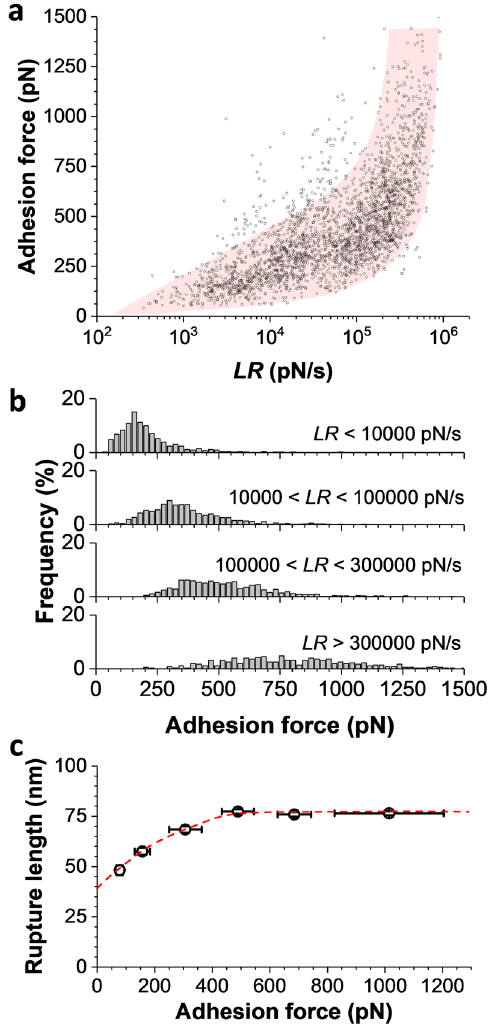
Fig. 6 Physical stress strongly enhances agglutination forces between MAT a and MAT α cells. a Dynamic force spectroscopic plot obtained by recording force – distance curves in PBS between MAT a and MAT α cells, with an applied force of 1 nN and a probing time of 1 s ( n = 2761 data points from N = 6 independent cell pairs). b Corresponding unbinding force histograms as a function of discrete ranges of LRs, emphasizing the shift toward higher forces with increasing stress. c Scatter plot of the rupture lengths observed according to different ranges of unbinding forces. The dashed red line is a guide for the